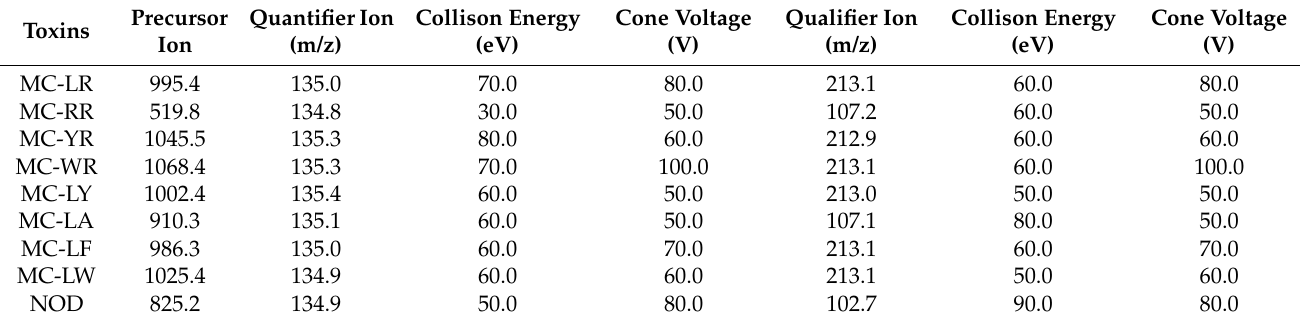
Table 1. MS/MS parameters used for ion